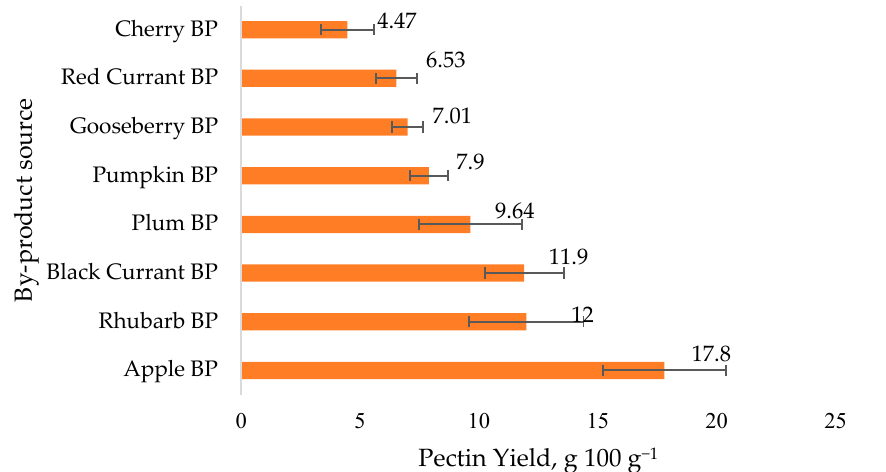
Figure 1. Pectin Yield from food production by-products with Citric Acid method. The data are presented as mean values (n = 3). Table 1. Properties of by-products after juice extraction.